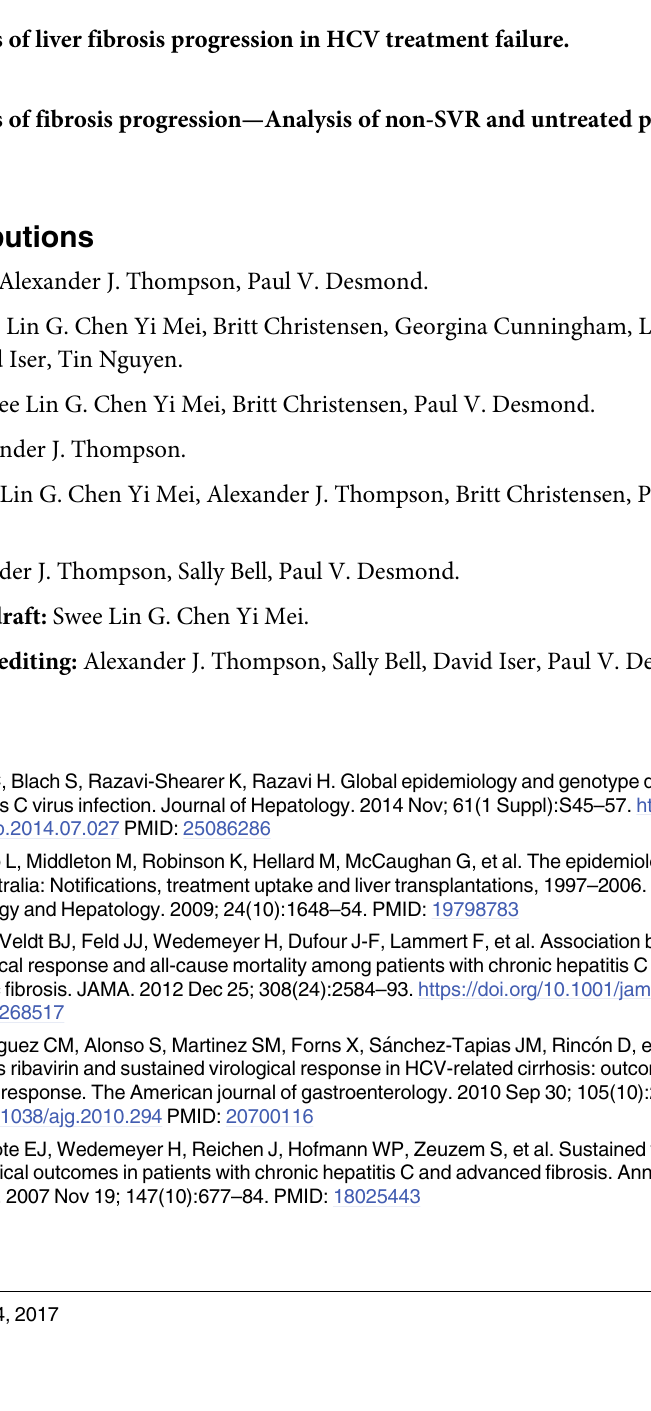
S1 Fig. A. Fibrosis staging of HCV cohort at baseline and follow-up (n = 114). B. Sustained virological response is associated with stable / improved liver fibrosis (n = 114). C. Persistent HCV is associated with liver fibrosis progression (n = 114). S1 Table. Predictors of fibrosis progression (F0-F3 vs. F4). S2 Table. Predictors of liver fibrosis progression in HCV treatment failure. S3 Table. Predictors of fibrosis progression—Analysis of non-SVR and untreated